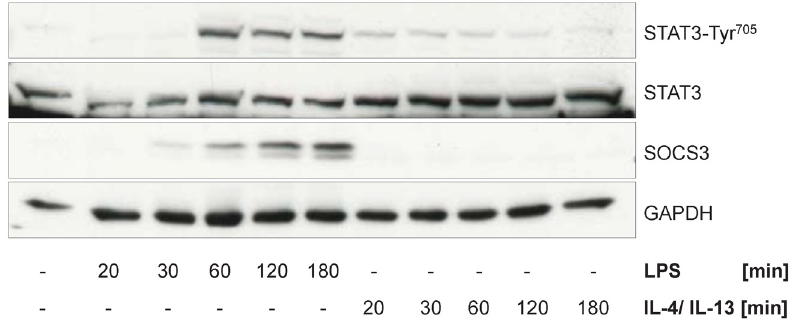
Fig 8. Jak/STAT signaling in response to LPS and IL-4/IL-13 stimulation. Primary murine BMDMs were stimulated with LPS (50 ng/ml) or IL-4/IL-13 (25 ng/ml each) for the times indicated and whole cellular protein extracts were prepared. 30 μ g of protein/lane were subjected to immunoblot analysis using antibodies specific for STAT3-Tyr 705 , STAT3, SOCS3 and GAPDH. Representative data for at least three independent experiments are shown.